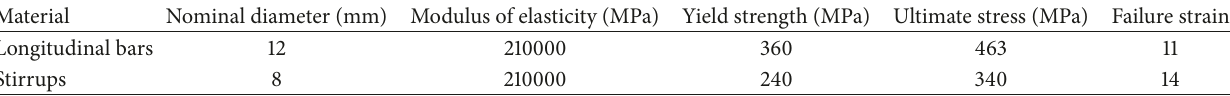
Table 2: Specifications of steel